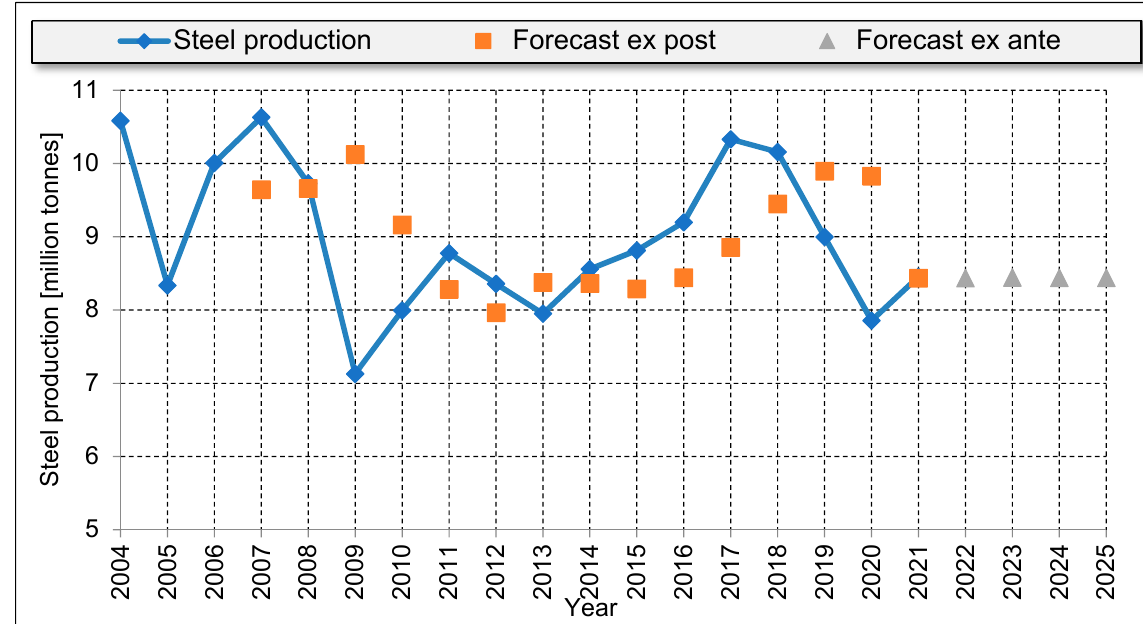
Table 2. Estimated energy and heat demand for forecasts of steel in 2022–2025 (variant 1A).